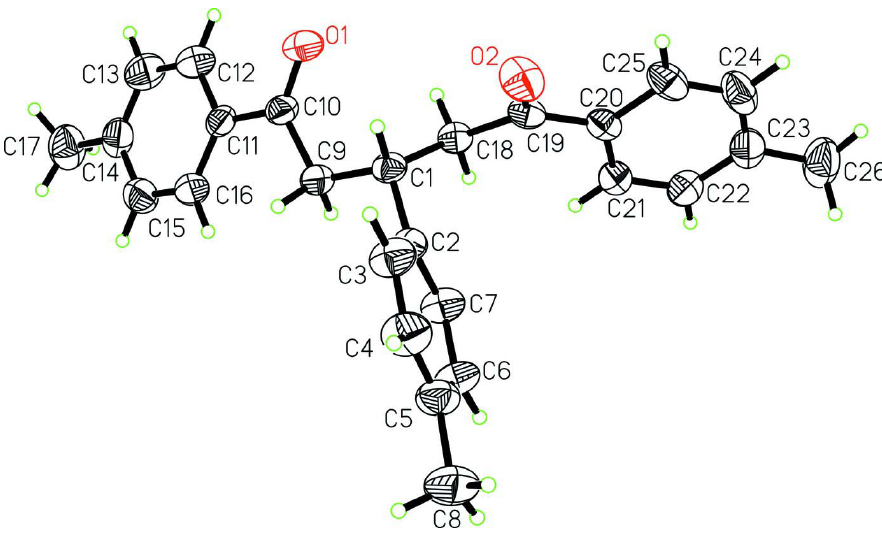
Figure 1 The molecular structure, with the displacement ellipsoids drawn at the 30% probability level. The H atoms are shown as spheres of arbitary radii.